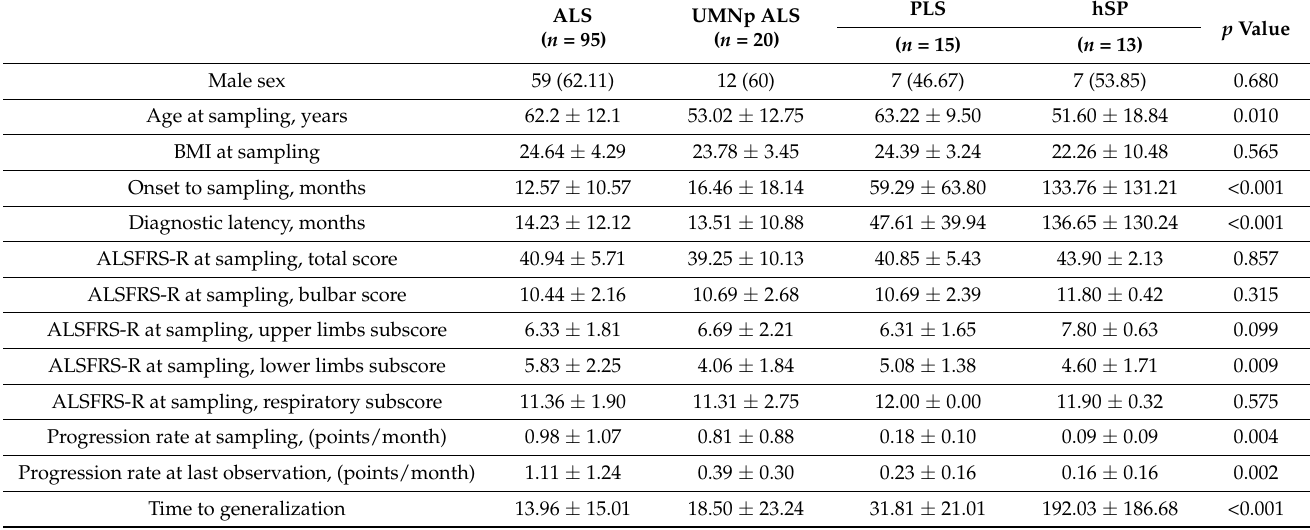
Table 1. Subjects’ clinical features in different